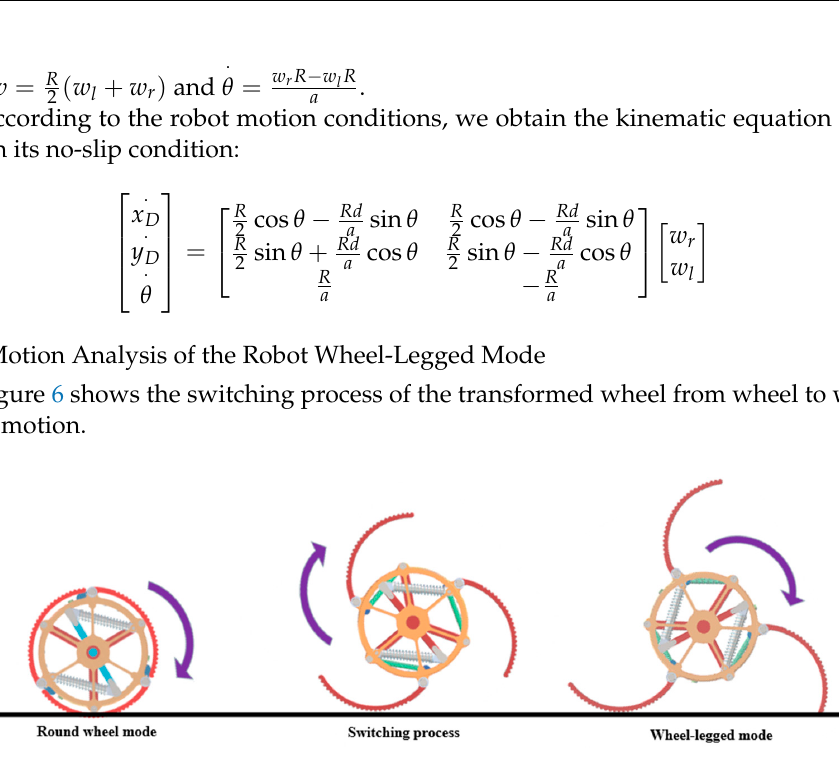
the transformed wheel motion process as T 0 = kT /3, T 1 = kT /3 + t 1 , T 2 = ( k + 1) T/ 3, where O 1 is the circle center of the transformed wheel, O 2 is the circle center of the circular arc segment of the wheel trigger leg, point B is the outermost endpoint of the wheel trigger leg 1, point C is the contact point between the wheel trigger leg 1 and the ground, and point D is the location point where the wheel trigger leg 2 is connected to the hub. The distance between O 1 and point B is the effective radius r w of the wheel, and the distance between point O 1 and point O 2 is L 1 , angle O 2 BO 1 = α 1 , angle O 1 O 2 P = α 2 , angle O 2 O 1 B = α 3 , and angle O 1 O 2 E = γ .